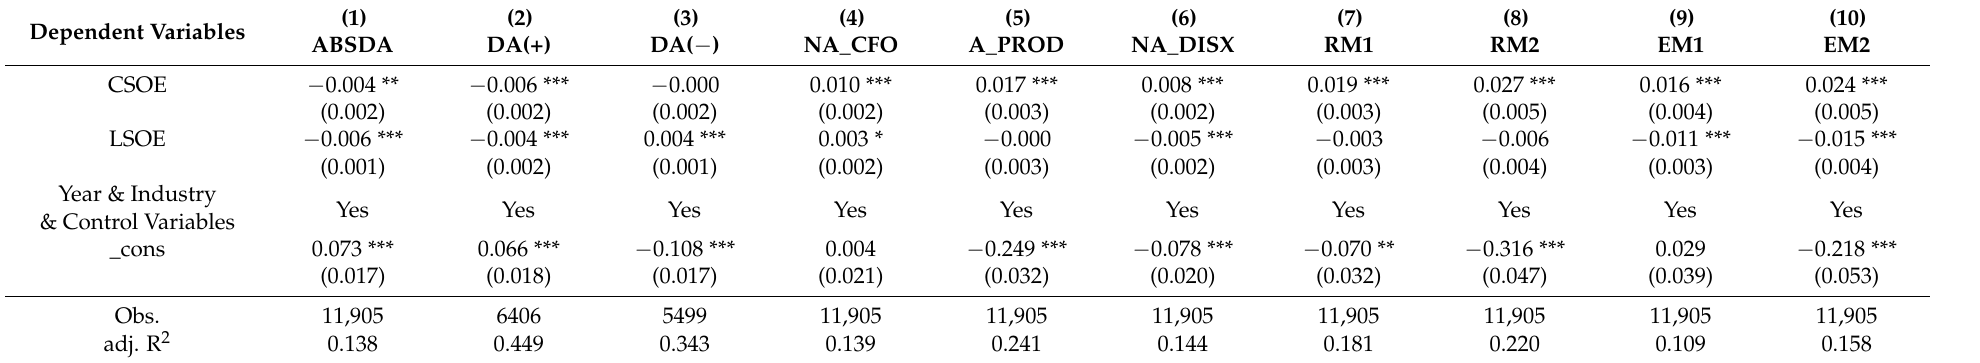
Table 9. The Effect of State Ownership Type on Real Earnings Management and Accruals Management.